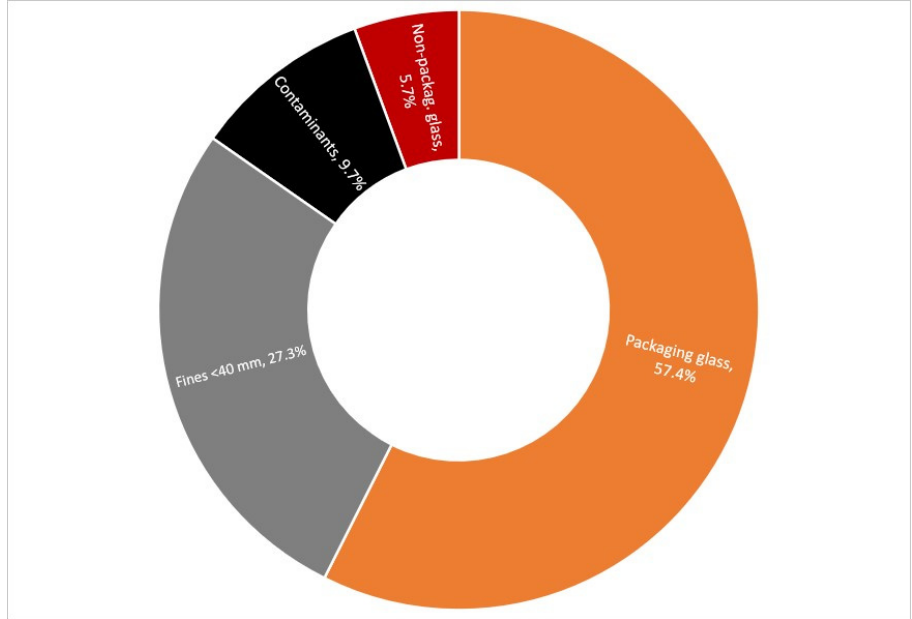
Figure 6. Composition of separately collected glass.